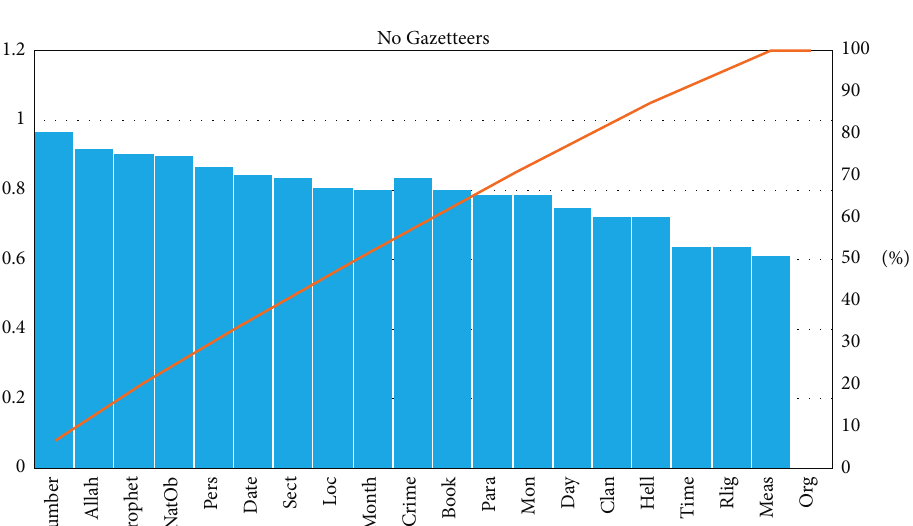
Figure 7: Results of not using